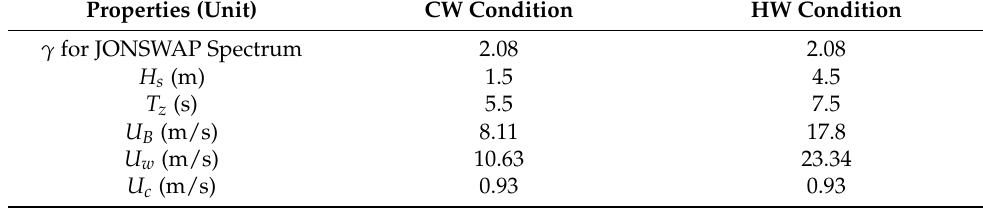
Figure 9. Schematic illustration of wind profile.